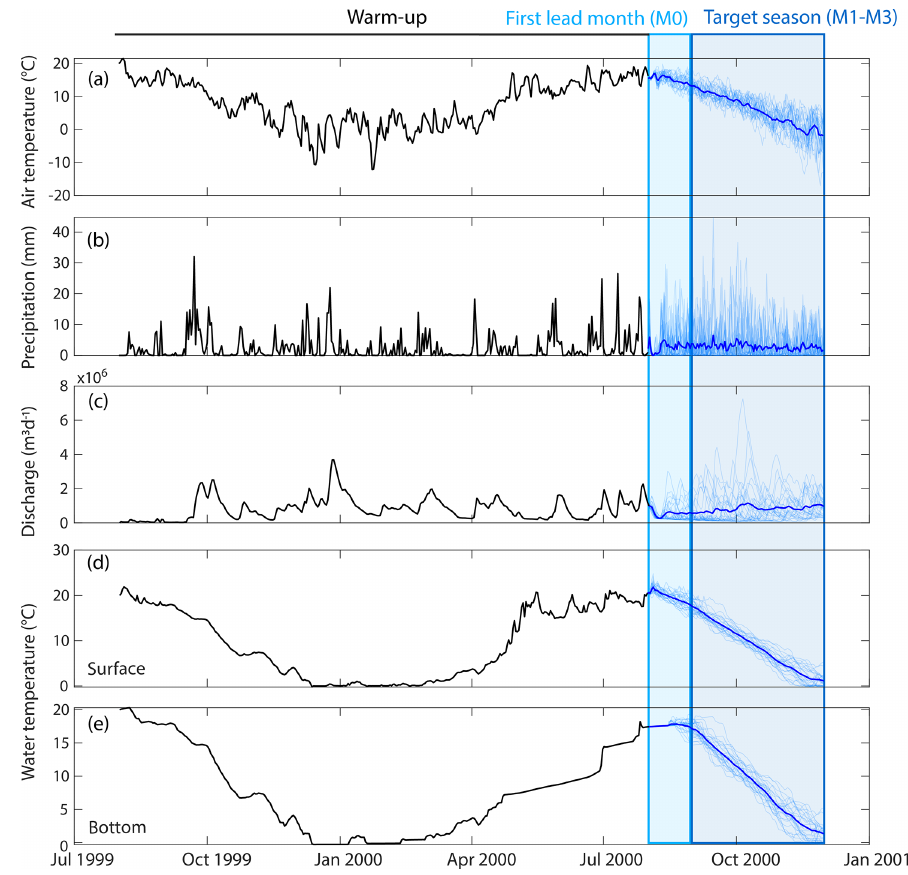
Figure 3. Time series of the air temperature (a) , precipitation (b) , discharge (c) , and surface (d) and bottom (e) water temperature over the warm-up, first lead month (M0) and target season (M1–M3) for autumn 2000. The black lines indicate ERA5 (a,b) and Lake_PO (c–e) data; the light- and dark-blue lines are, respectively, the 25 members and the mean of SEAS5 (a,b) and Lake_F (c–e)